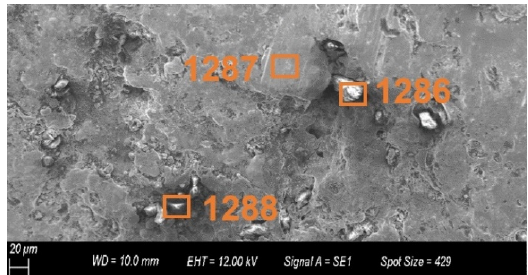
Figure 15. Points analyzed in the fixed contact of Figure 6b, in the “Cut X” zone.